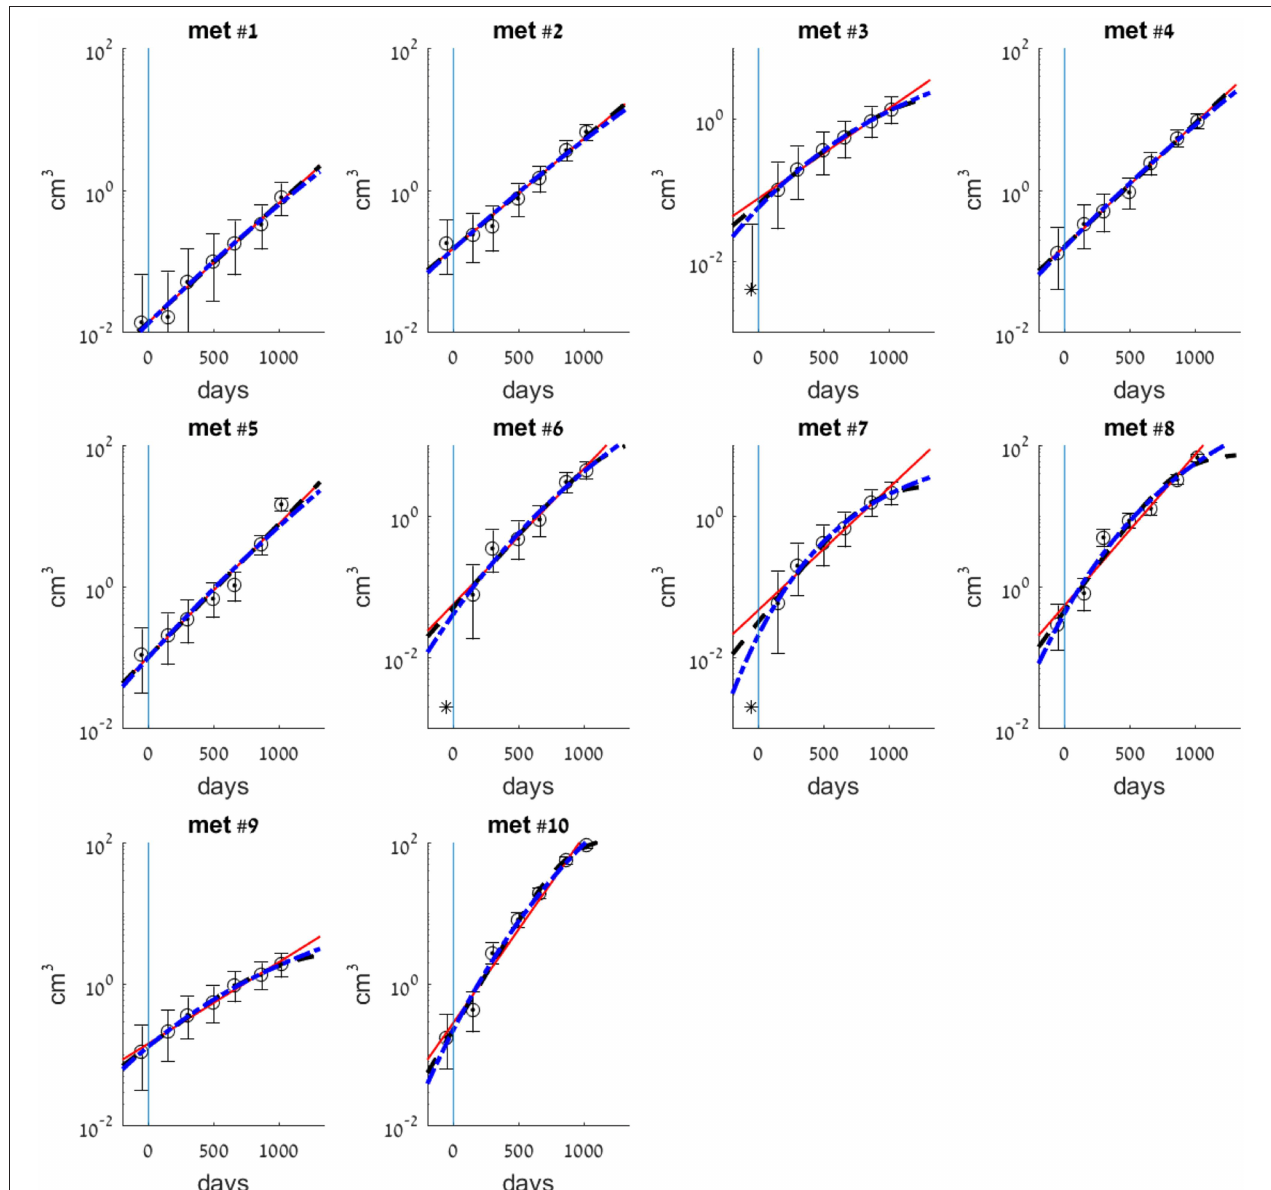
FIGURE 1 | Exponential (smooth red line), logistic (dashed black line), and Gompertzian (dashed-dotted blue line) growth law fits for each of the 10 metastases. Model parameters were fitted to observed volumes of metastases as measured by CT scans at times W1–W7 (see Table 1 ). Circles are clinical measurements that models were fitted to. Asterisk at time W1 ( t 54 days) in met #3 is detected size, that was not used for the fit. Asterisks in mets #6 and #7, which were not detected at time = W1, mark detection limit 0.002 cm 3 . Vertical line at t 0 marks the day of primary tumor =